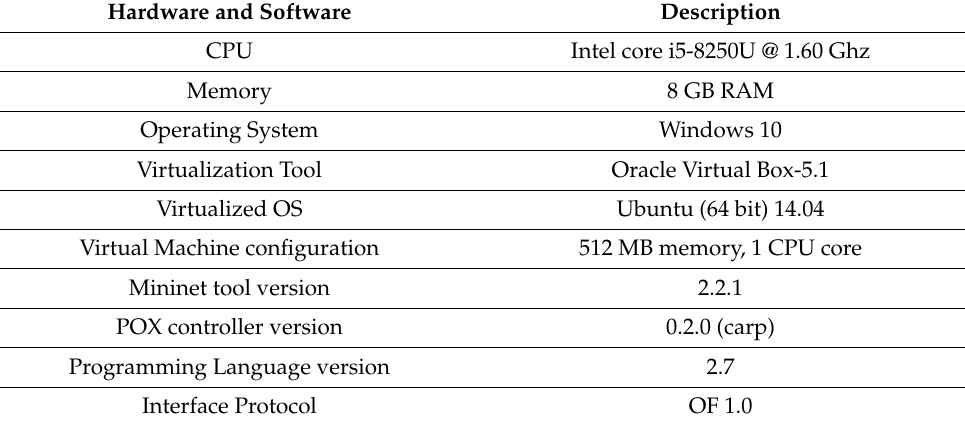
Table 1. Simulation